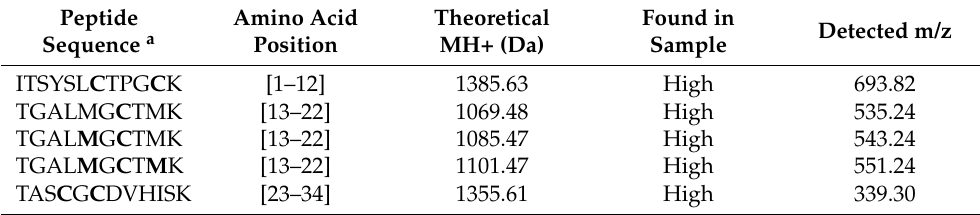
Table 2. Peptide fragments identified by targeted proteomics combined with massive peptide analysis of nisin S, in the RP-FPLC-purified fractions from L. salivarius P1CEA3.